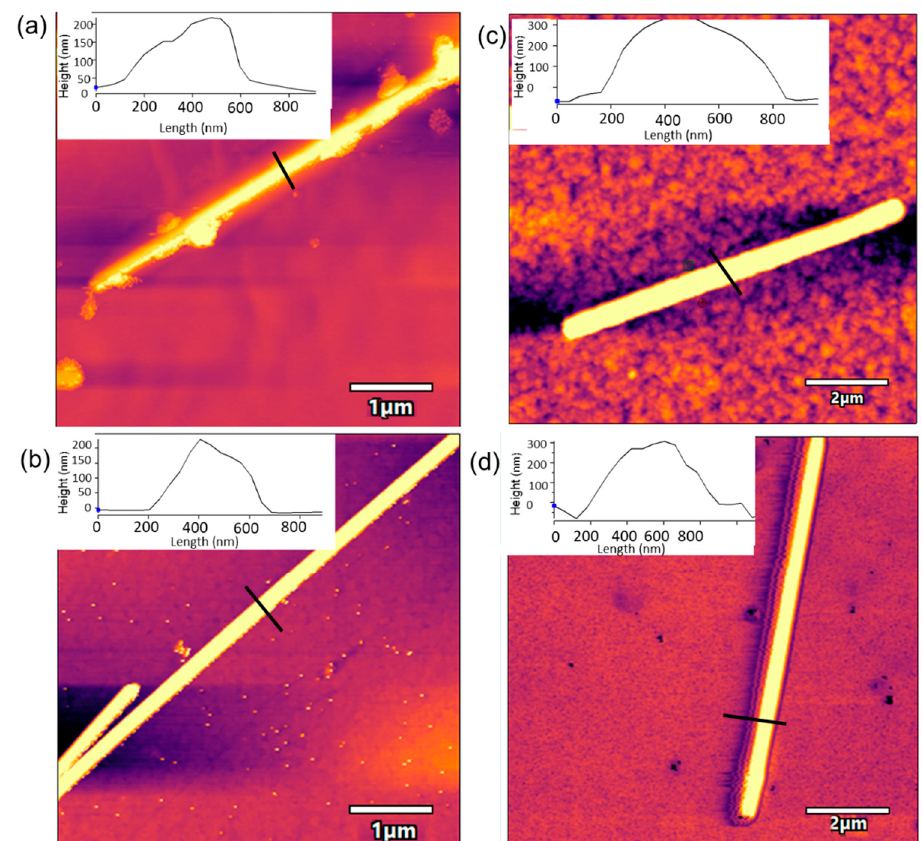
Figure 9. AFM image of ( a ) ITO-AgNWs sensor after voltammetry, ( b ) ITO-AgNWs sensor after voltammetry and washing with water, ( c ) AgNWs-Tyr biosensor after voltammetry and ( d ) AgNWs-Tyr biosensor after voltammetry and washing with water.